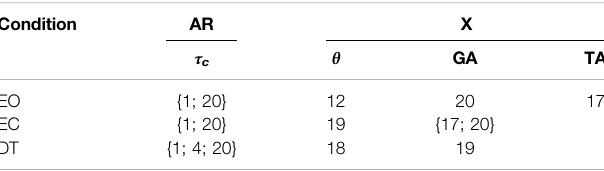
TABLE 1 | The fi ve ARX components selected by the mRMR algorithm for the threeaugmentedregressionspacesnamely,EO,EC,andDT,intermsoftime- series lags chosen.